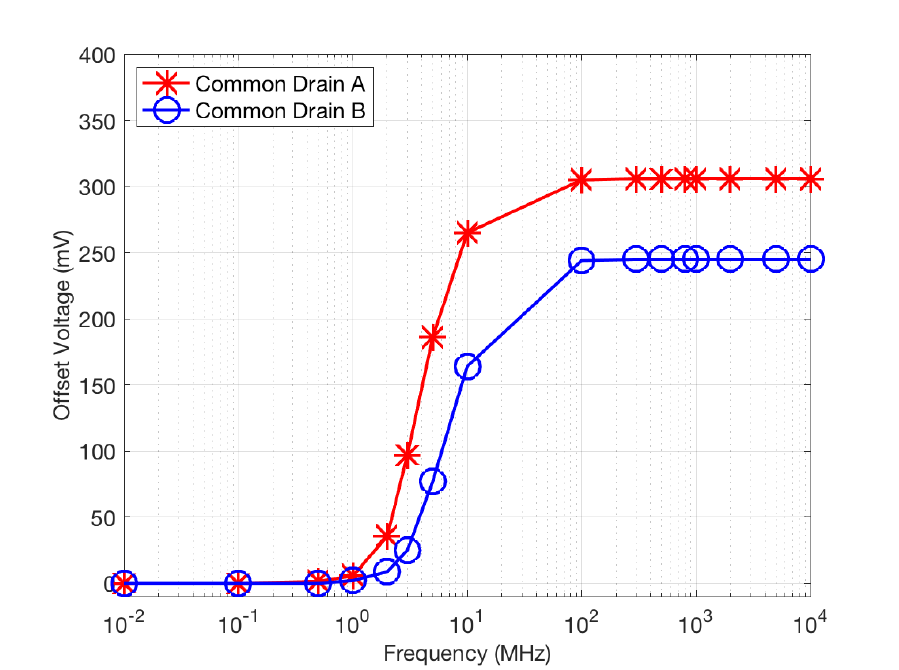
Figure 14. EMI induced offset in the common drain